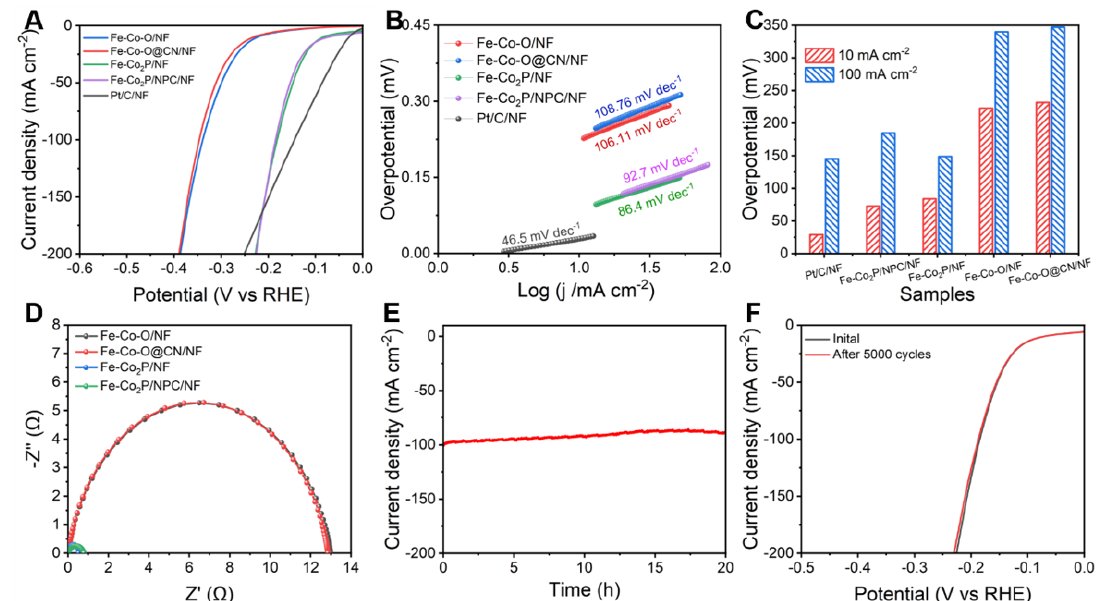
Figure 3. The HER performance of different catalysts: ( A ) polarization curves, ( B ) Tafel slope, ( C ) overpotentials, ( D ) EIS Nyquist plots, ( E ) chronoamperometry curve of Fe-Co 2 P/NPC/NF recorded for 20 h at 100 mA cm − 2 , and ( F ) polarization curves of Fe-Co 2 P/NPC/NF before and after stability testing.